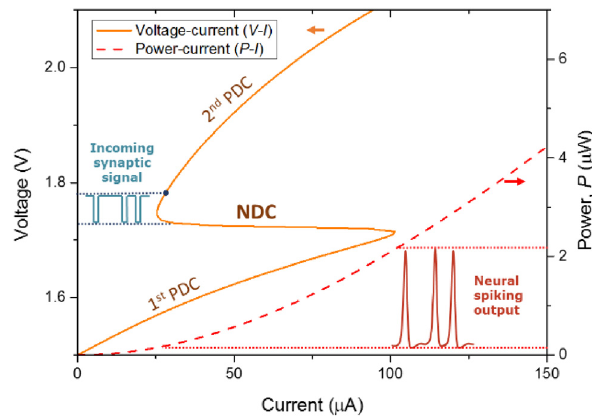
Figure 2: Light-current-voltage characteristics of the neuromorphic nanoLEDshowingthe V - I nonlinearvoltage-controlledcurrentcurve, i(V )(yellowsolidtrace),andthe P - I curve(red-dashedtrace).The i ( V ) with a region of NDC enables voltage induced on-off current switching upon an incoming synaptic-like signal resulting in an all- or-nothing neural spiking output in the optical